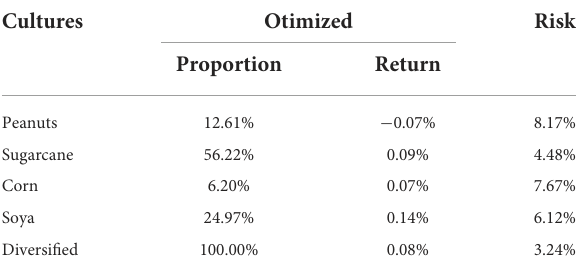
TABLE 7 Proportion, return and risk of